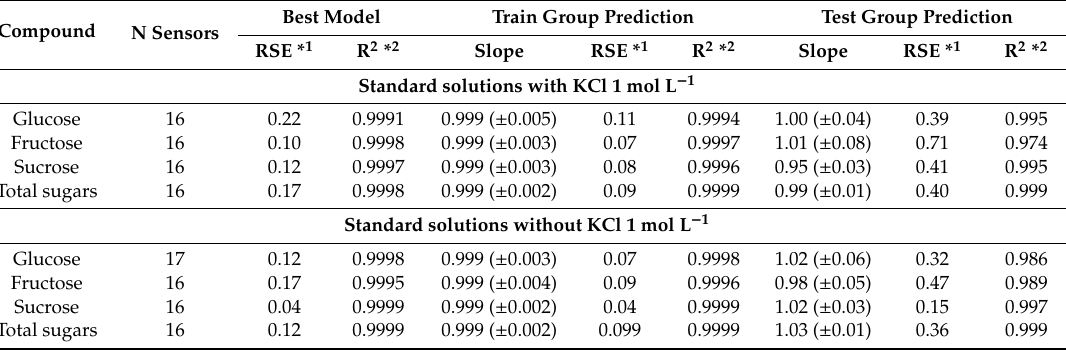
Table 4. Results from the quantifications of sugars (glucose, fructose and sucrose) and total sugars’ contents in the standard solutions, with and without KCl 1 mol L − 1 , using potentiometric multi-sensor data through MLR models for the training and test group